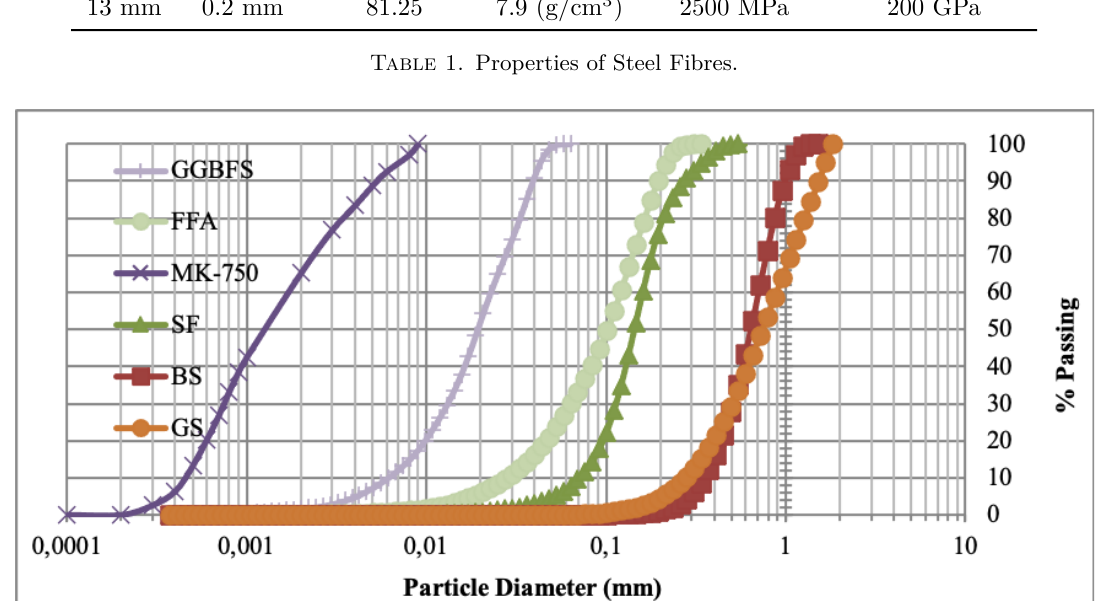
Figure 1. Particle Size Analysis of dry